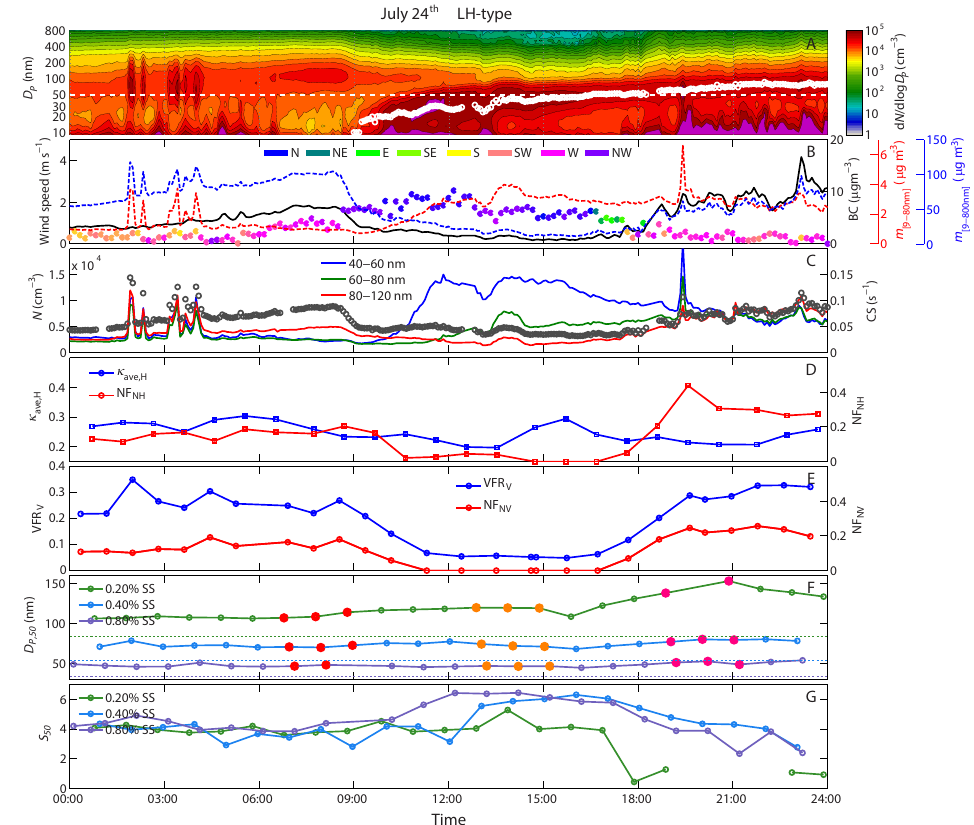
Figure 6. LH-type NPF event on 24 July. Time series of (a) particle number size distribution and geometric mean diameter of nucleation mode, (b) wind speed/direction and the mass concentration of BC, sub-80, and sub-800nm particles, (c) condensational sink (CS) and number concentration of particles in defined size ranges, (d) average κ of hygroscopic mode and number fraction of nearly hydrophobic mode for 50nm particles, (e) volume fraction remaining of volatile mode and number fraction of non-volatile mode for 50nm particles, (f) D P , 50 for 0.20, 0.40, and 0.80% SS, as well as (g) S 50 for the three SS. The dashed lines in (f) show the theoretical critical diameters for ammonium sulfate at the three SS. Points filled with color in panel (g) show the records selected to calculate the average size-resolved activation ratio shown in Fig.